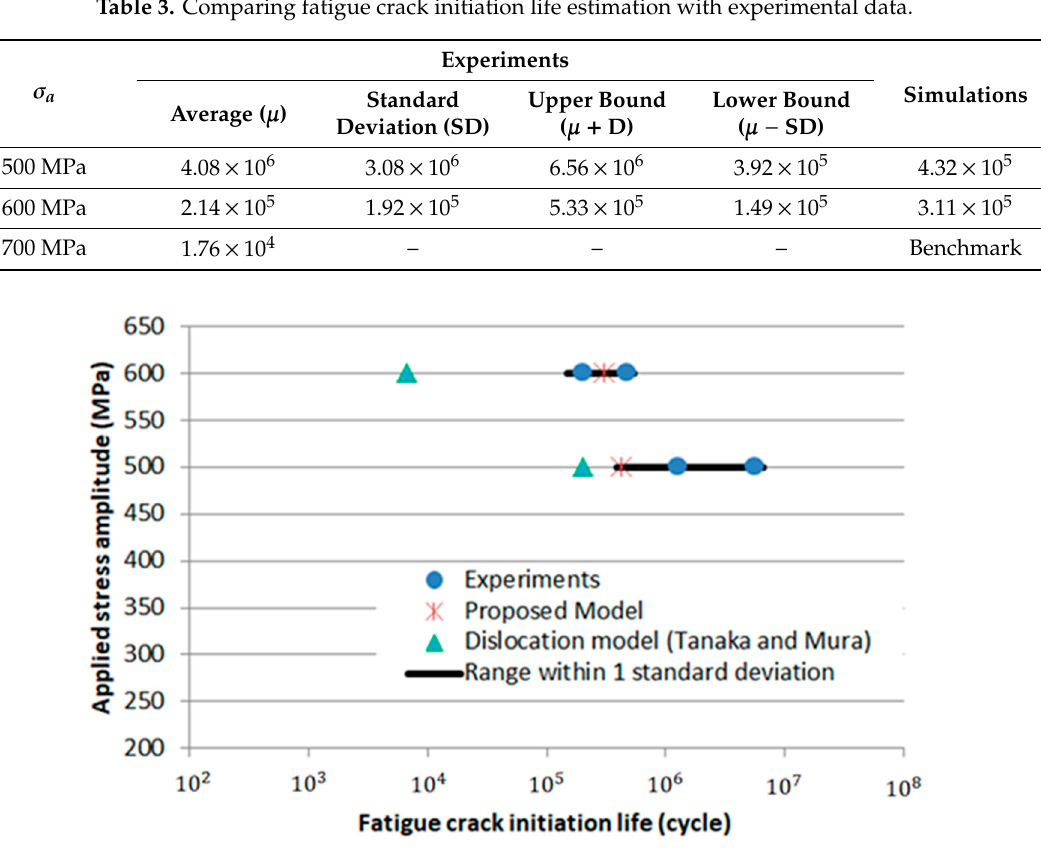
Table 3. Comparing fatigue crack initiation life estimation with experimental data.